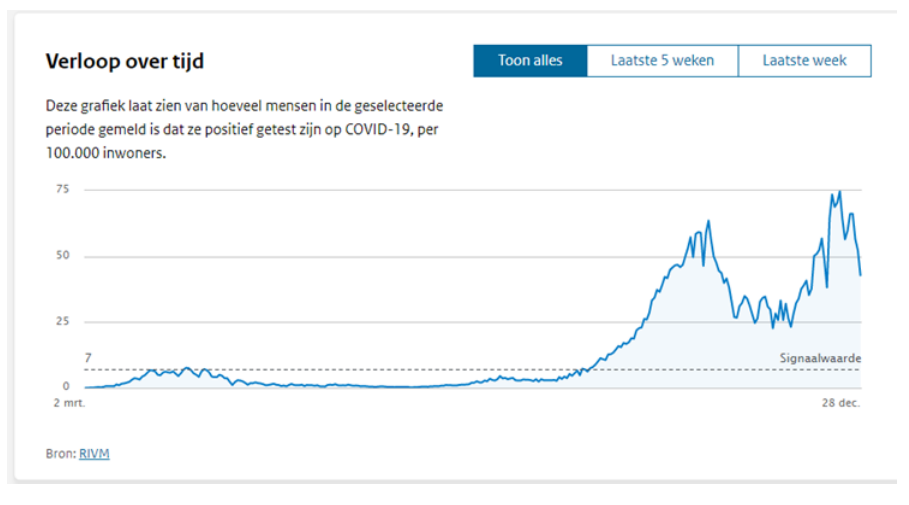
Figure 4. Number of hospitalized people ( a ) and COVID-19 cases ( b ) for the period 18–31 March 2020 per 100,000 inhab- itants per municipality [23].